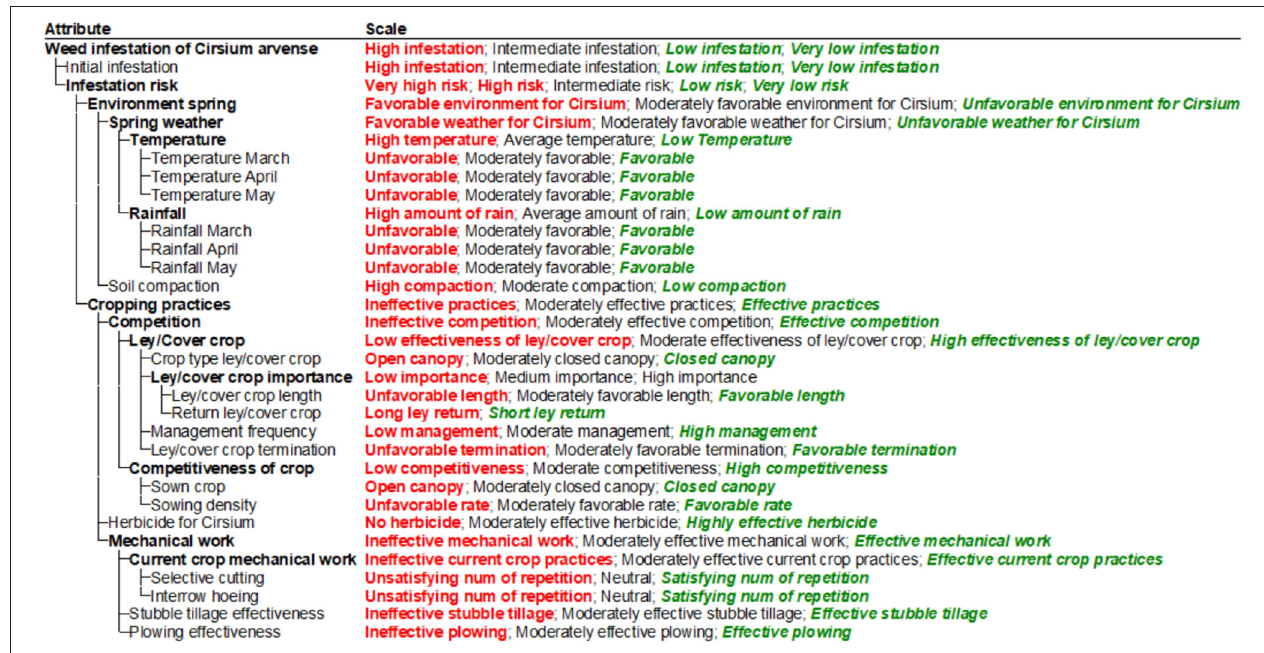
FIGURE 2 | Attribute scales of IPSIM-Cirsium. All of the scales are ordered from values favorable to Cirsium arvense (i.e., detrimental to the user) on the left-hand side (Red color) to values unfavorable to Cirsium arvense (i.e., beneficial to the user) on the right-hand side (Green color). (screenshot of the DEXi software).